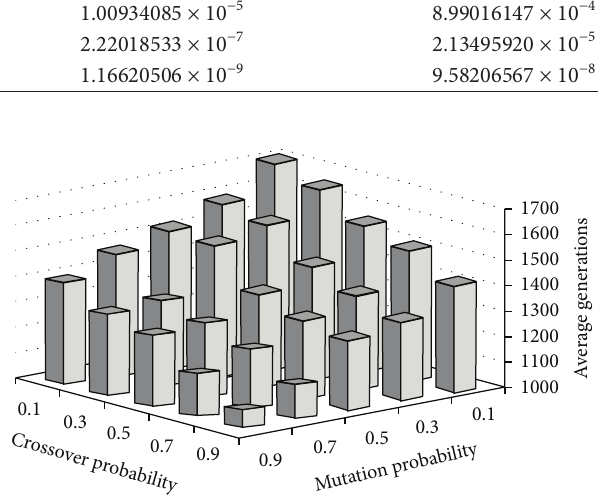
Figure 7: The effect of the crossover and mutation probabilities on the convergence speed of the algorithm for Troesch’s problem when 𝜆 = 0.5